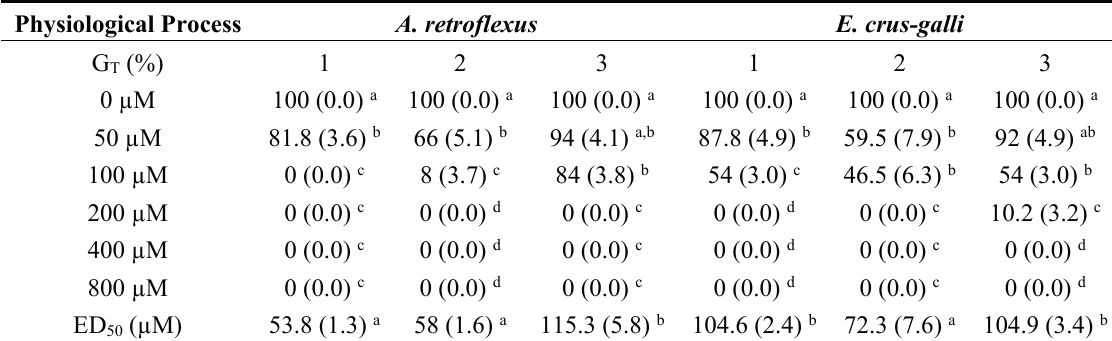
Table 1. Effects of the coumarin derivatives 1 – 3 on seed germination (GT %), speed of germination (S), speed of accumulated germination (AS) and Total Root Length (TRL) of A. retroflexus and E. crus-galli